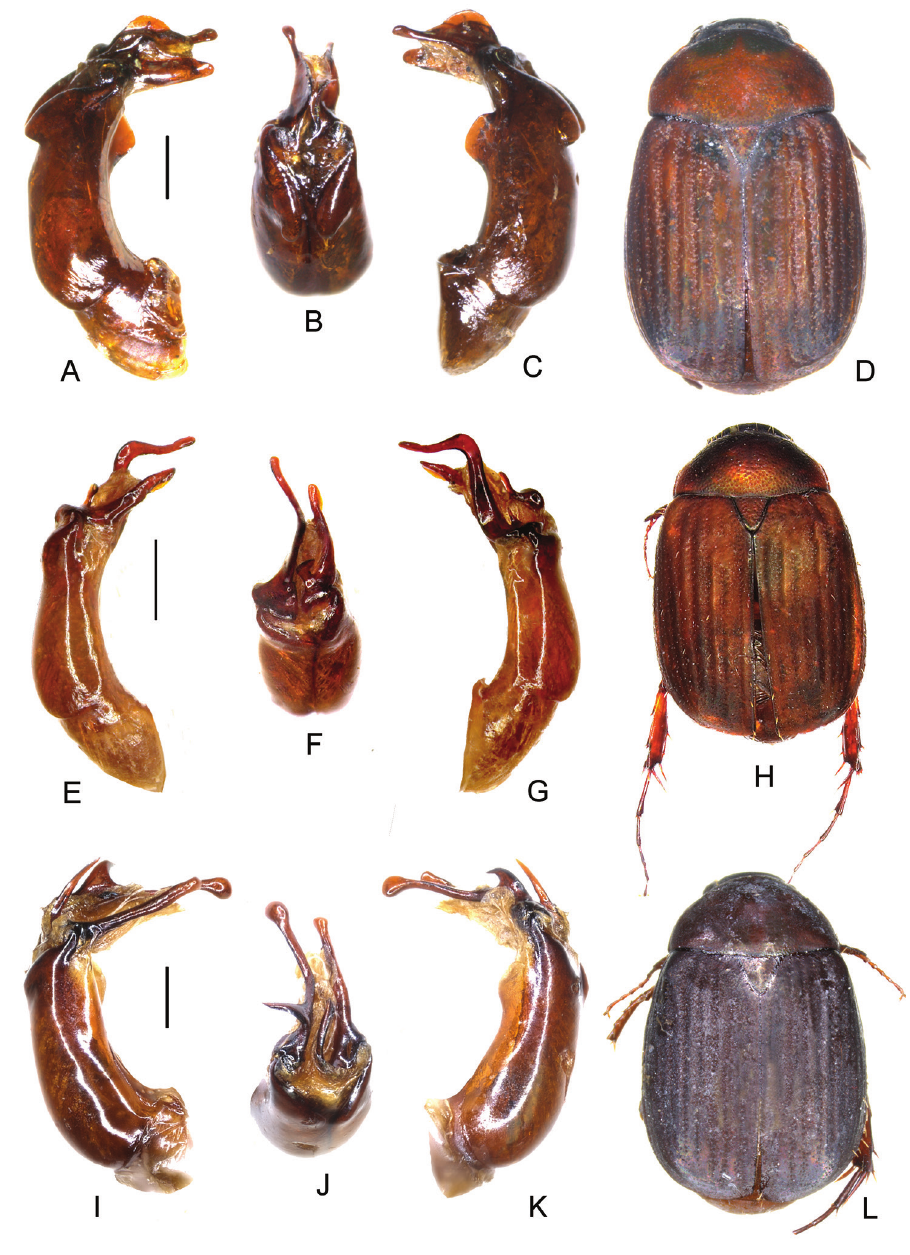
Figure 3. A–D Neoserica hainana (Brenske) (lectotype) E–H N. shoyungi Ahrens, Fabrizi & Liu, sp. n. (holotype) I–L N. sakoliana Ahrens, Fabrizi & Liu, sp. n. (holotype) A, E aedeagus, left side lateral view C, G aedeagus, right side lateral view B, F parameres, dorsal view D, H habitus. Scale bars: 0.5 mm. Habitus not to